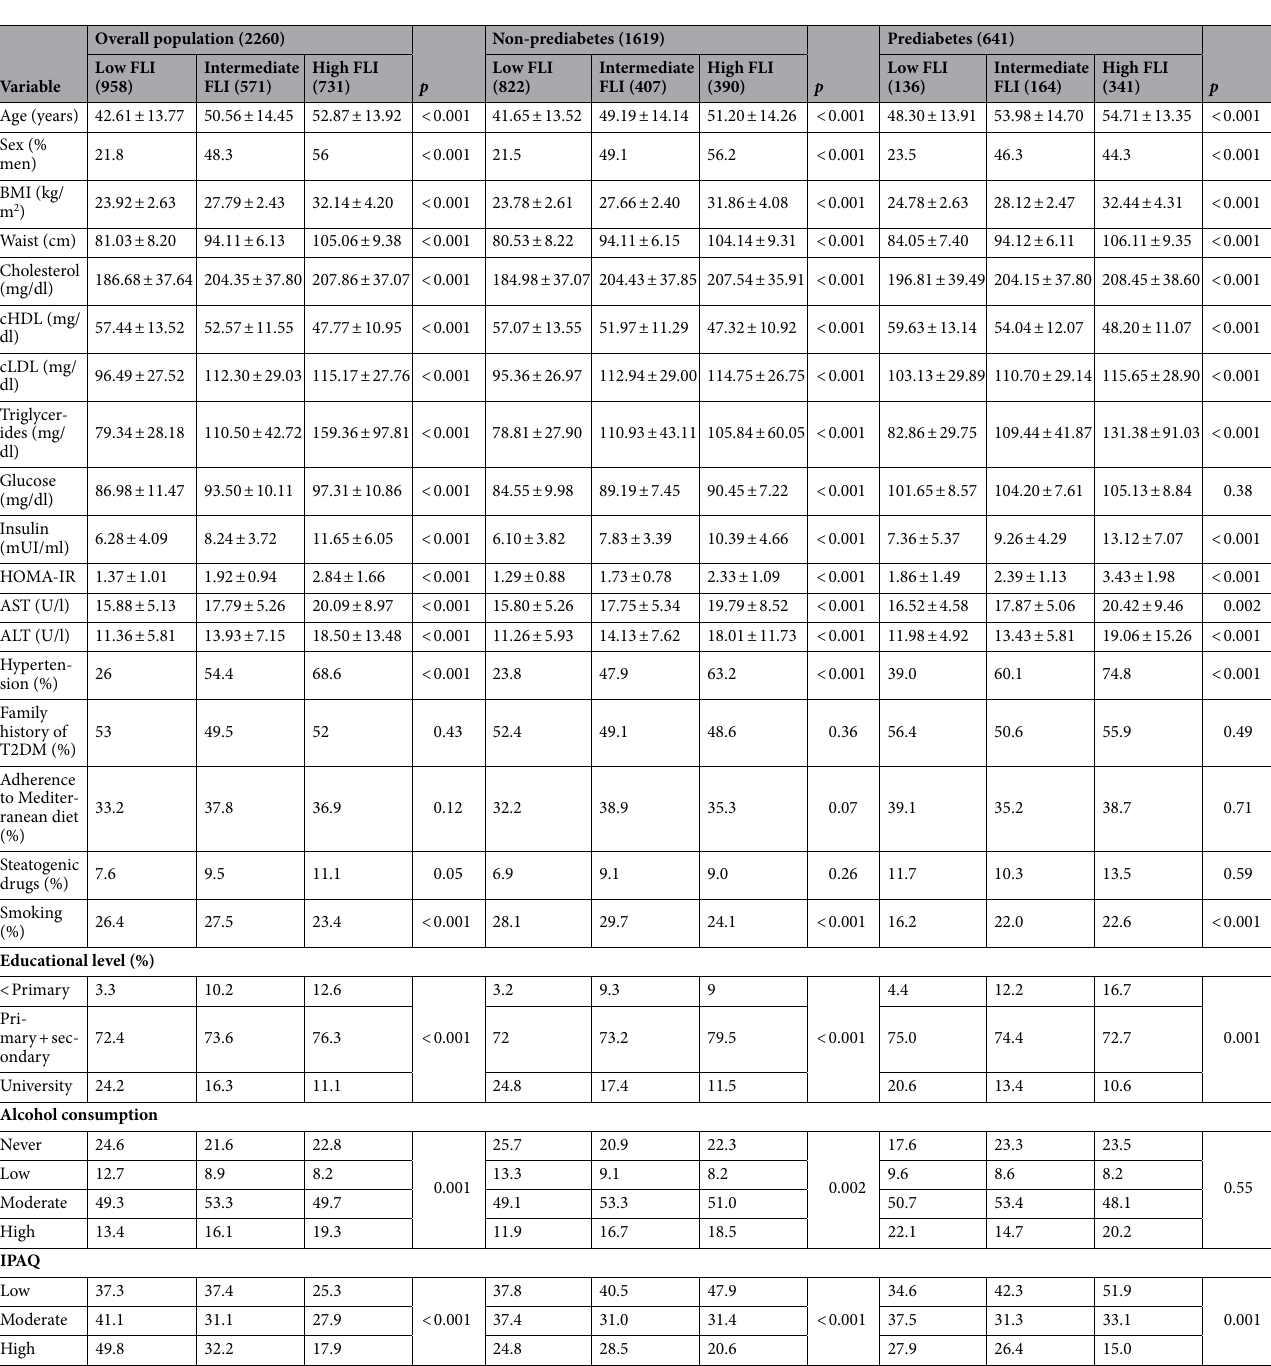
Table 1. Baseline characteristics of the subjects according to FLI categories. p = signification level of sex, age and BMI adjusted ANOVA or McNemar